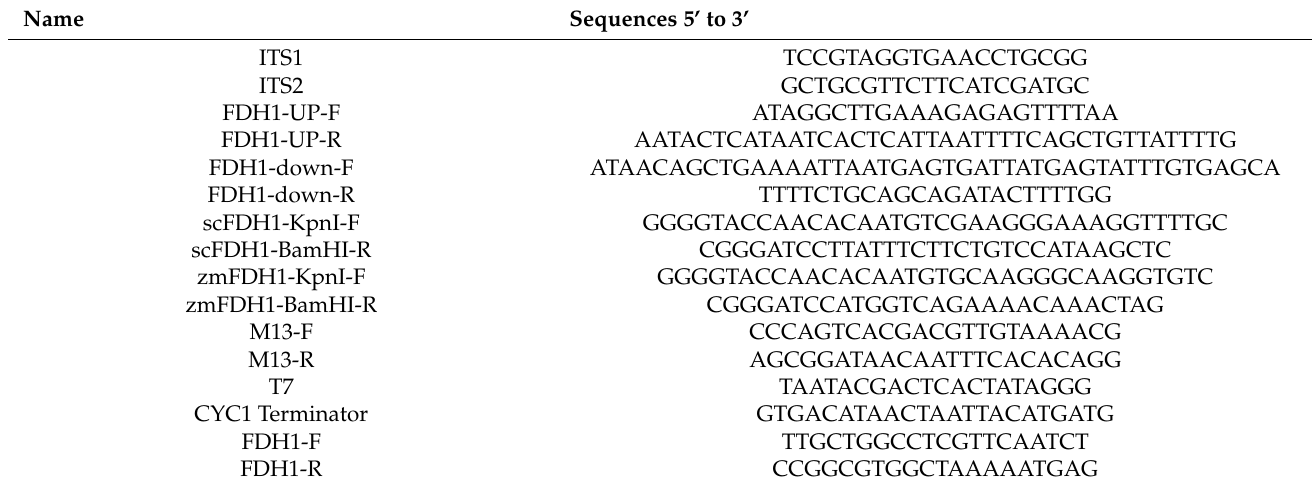
Table 1. Primers used in this study.